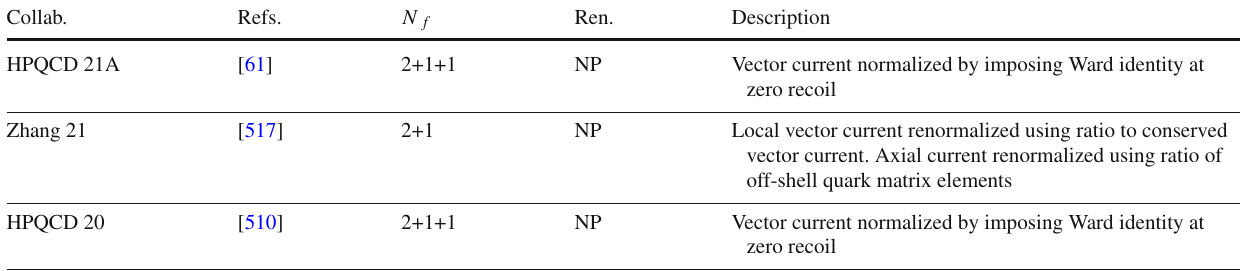
Table 138 Operator renormalization in determinations of form factors for semileptonic decays of charmed hadrons Collab.